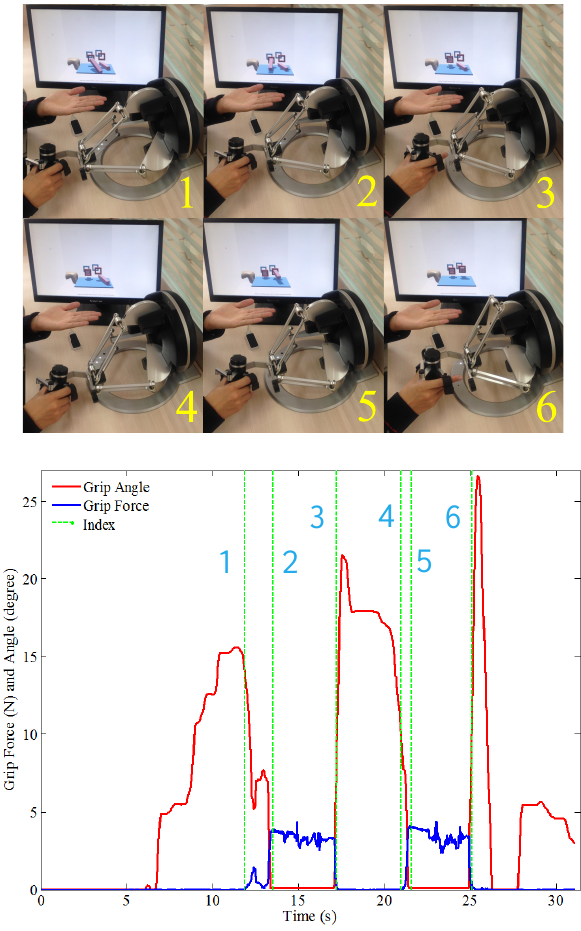
Figure 10. Procedures of each operation. Before 1: the hand is detached; the grip force is about zero; and the gripper angle is uncontrolled. Between 1 and 2: the user grips the first block; the grip force grows; and the gripper angle decreases. Between 2 and 3: the user moves the first block to the target brace; the grip force persists; and the gripper angle remains low. Between 3 and 4: the first block is in place; the gripper moves to the second block; the grip force is low; and the gripper is opened for the second grip. Between 4, 5 and 6: repeats 1, 2 and 3 for the second block. After 6: operation accomplished; no grip force; and the gripper angle is